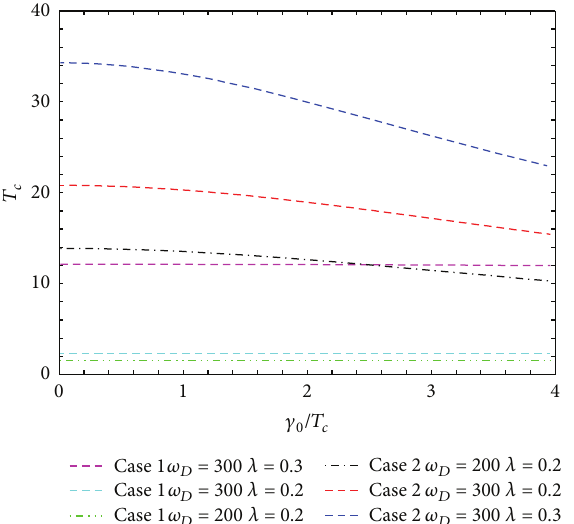
Figure 2: The gap-to- 𝑇 𝑐 ratio of Cases 1 and 2 with varied hybridization coefficients.